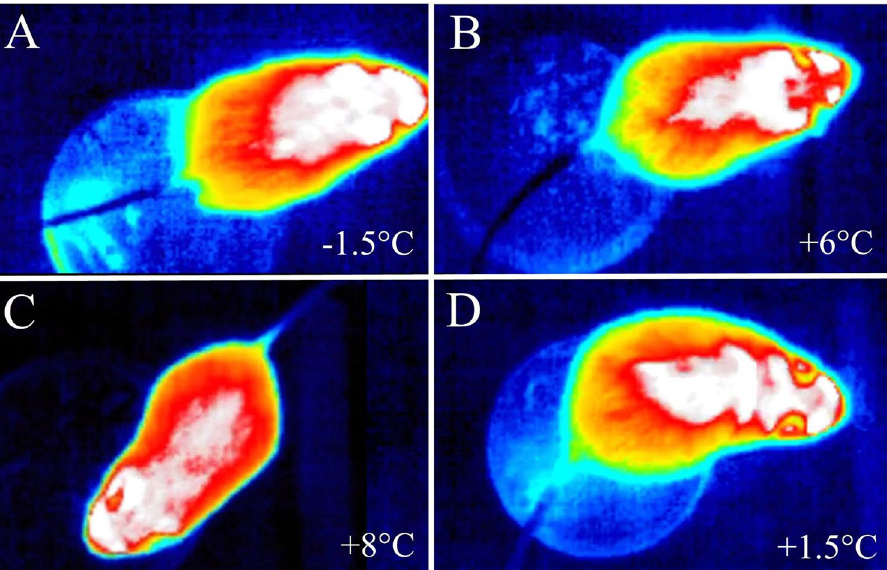
Figure 2. Thermal images showing temperature of the tail equaling ambient temperature (for NETD = 70mK). ( A – C ) a striped field mouse; ( D ) a yellow-necked mouse. NETD = noise equivalent temperature